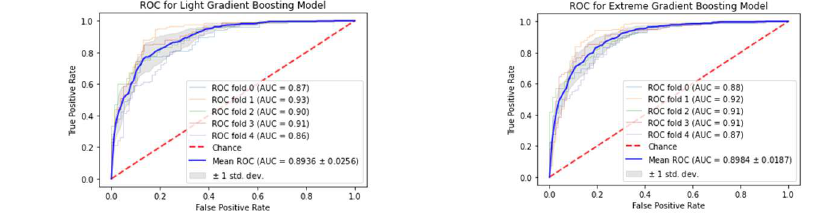
Figure 8. ROC Curves for all Gradient Boosting models on pooled data.